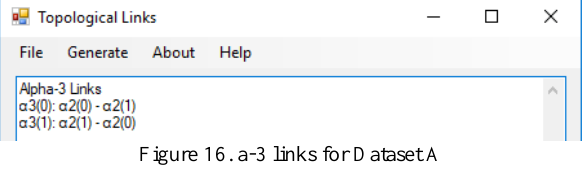
Figure 16. a-3 links for Dataset A